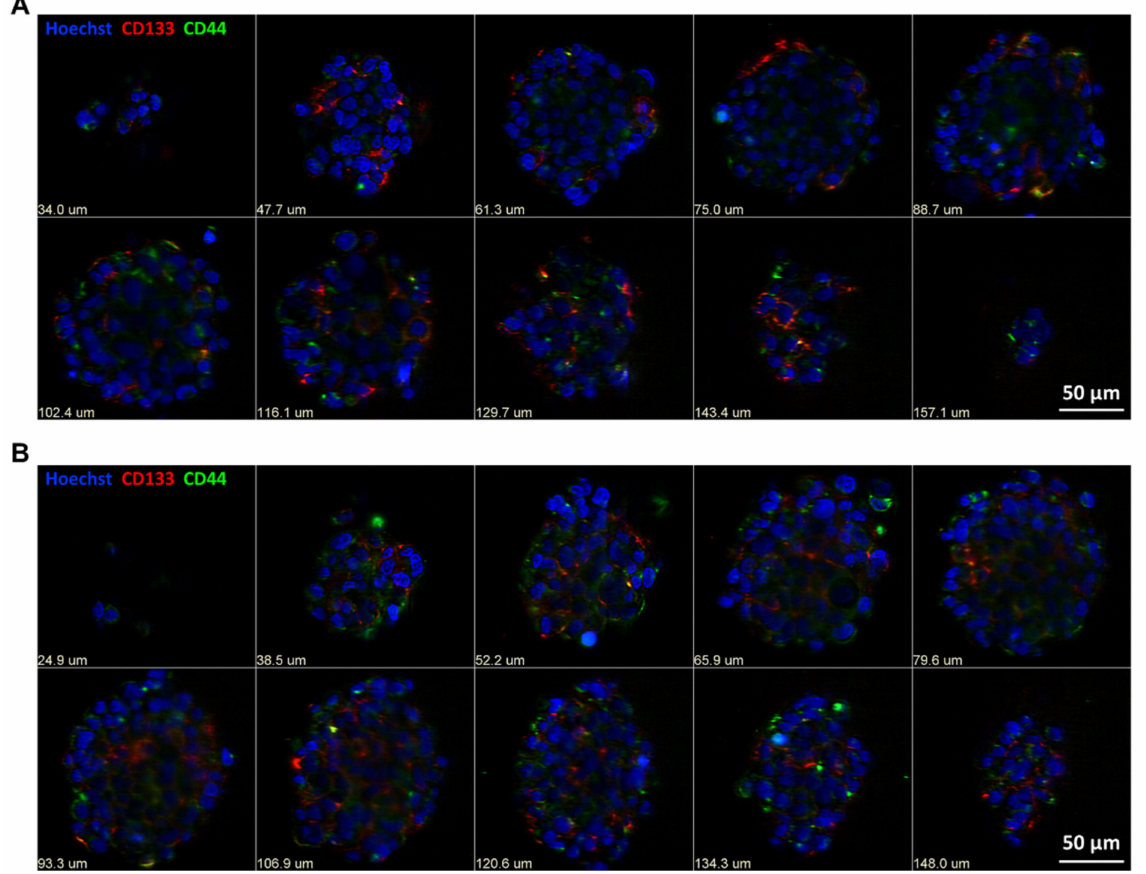
Figure 3. Subsets of CD133 and CD44 biomarker-negative cells convert into biomarker-positive GSC cells. ( A,B ) Light Sheet Florescence Microscopy (LSFM) was used to assess the expression of CD133 and CD44 positive cells in GTCC-10 gliomaspheres; representative images are shown here; scale bar = 50 µ m; steps between optical slices indicated in µ m; n = 3 independent experiments performed in